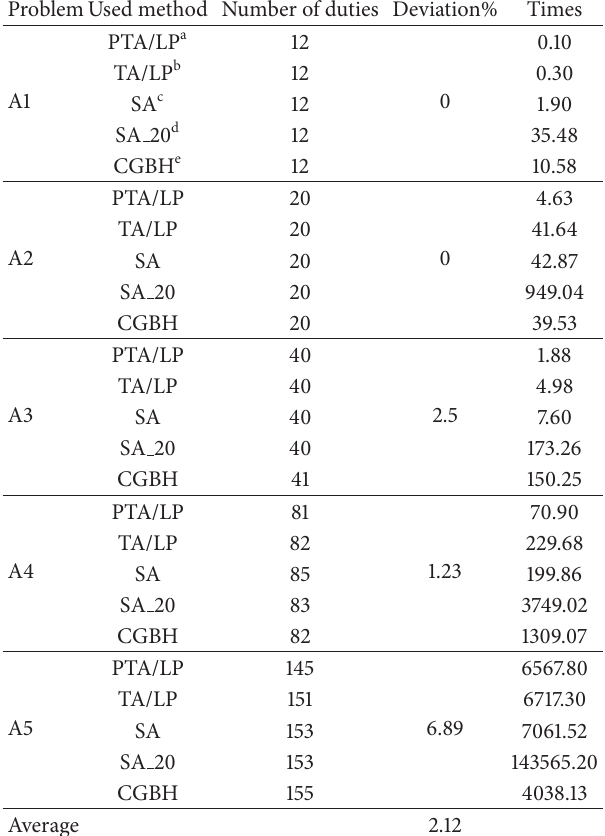
a Population training algorithm/linear programming with more iterative. b Population training algorithm/linear programming with few iterative. c Simulated annealing. d Simulated annealing with 20 executions. e Colunm generation based hyper-heuristic